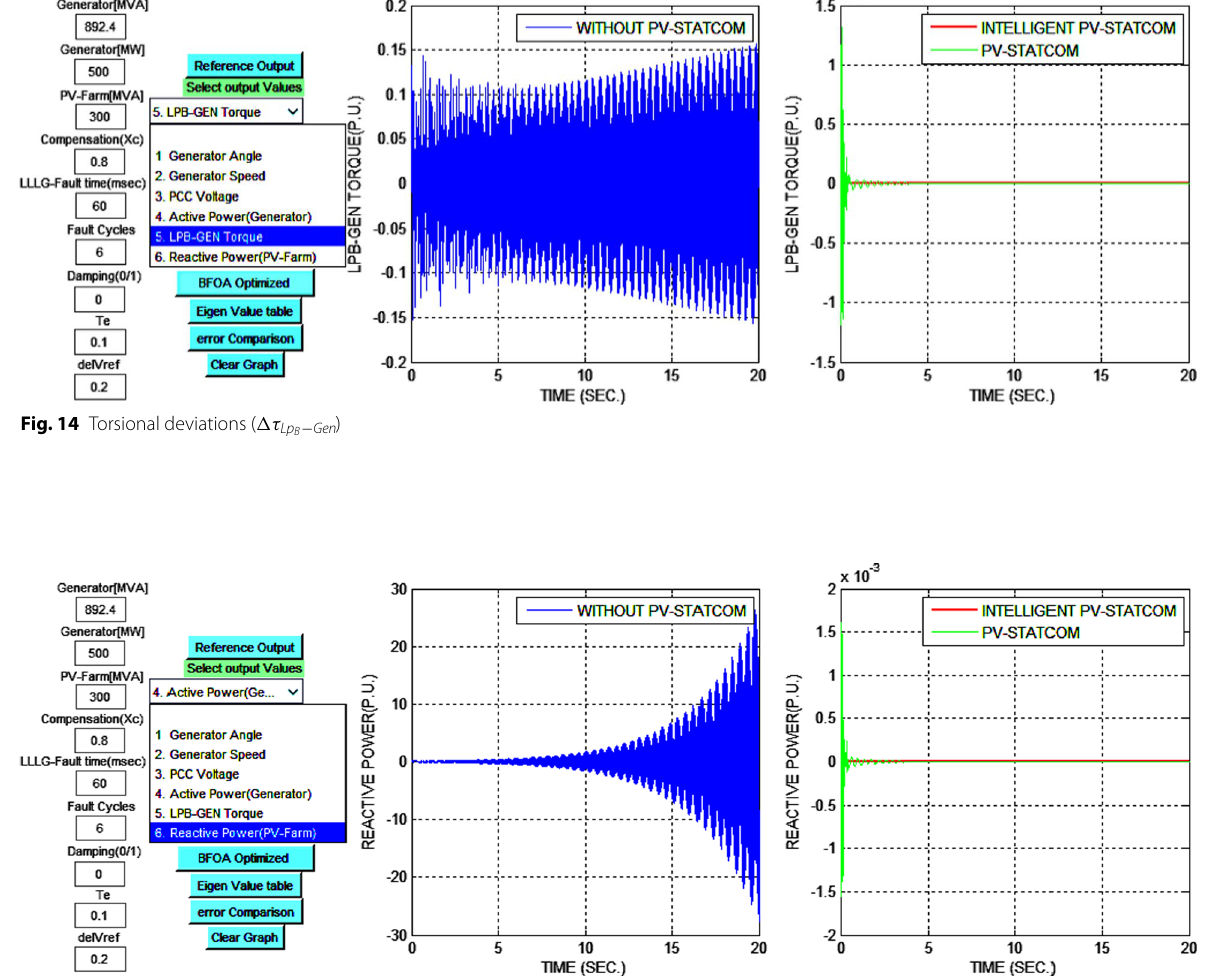
Fig. 15 Reactive power deviations